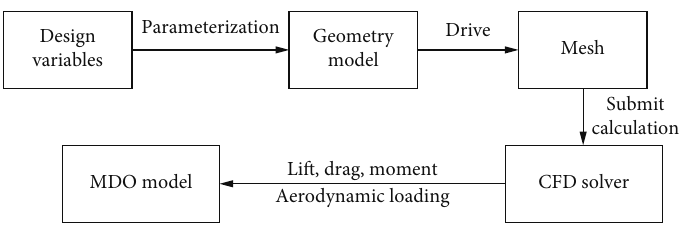
Figure 13: Parameterization process of the aerodynamic analysis module.